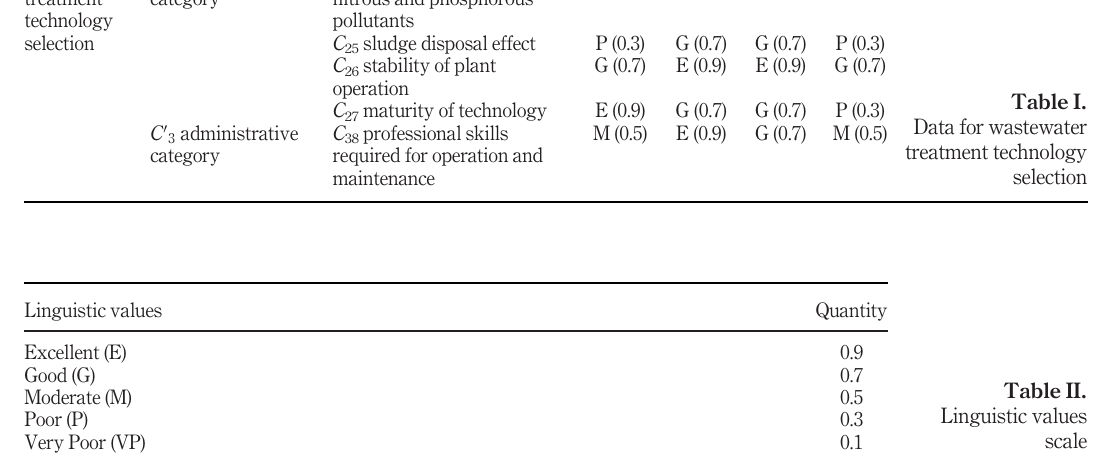
Table I. Data for wastewater